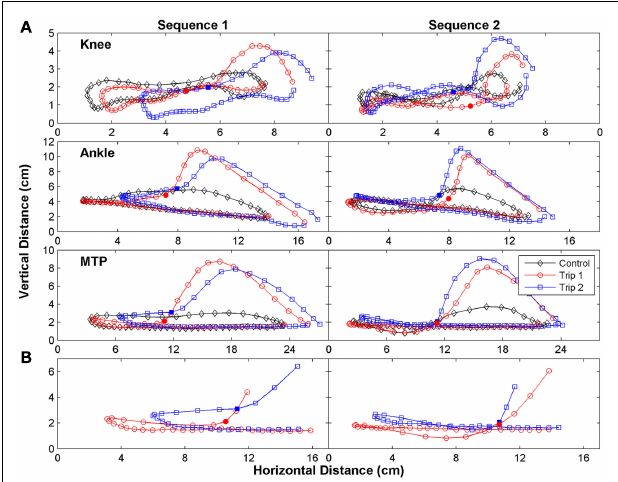
FIGURE 2 |The time course of the changes in the hip, knee, and ankle joint angles during the swing phase for a control,Trip 1, andTrip 2 step are shown for two tripping sequences in a representative cat. The solid symbols indicate the time when the foot touches the trip rod.The kinematics ofTrip 2 reflect an adaptive response relative toTrip 1 at all three joints in both sequences.The stick figures in Figure 1B were generated from the data shown for the first sequence.